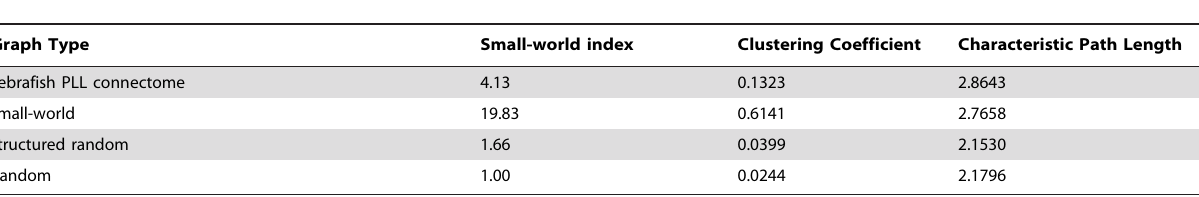
Table 2. Small-world index, Clustering Coefficient, and path length averaged across 100 instantiations for each graph model.